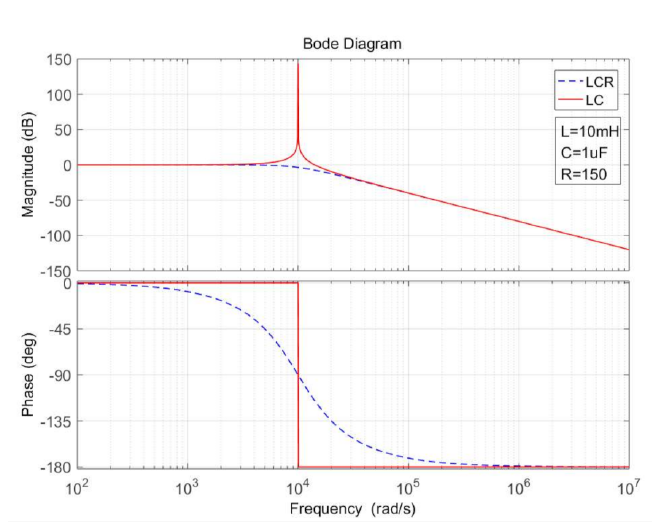
Figure 8. The bode waveform of LC filter and LCR